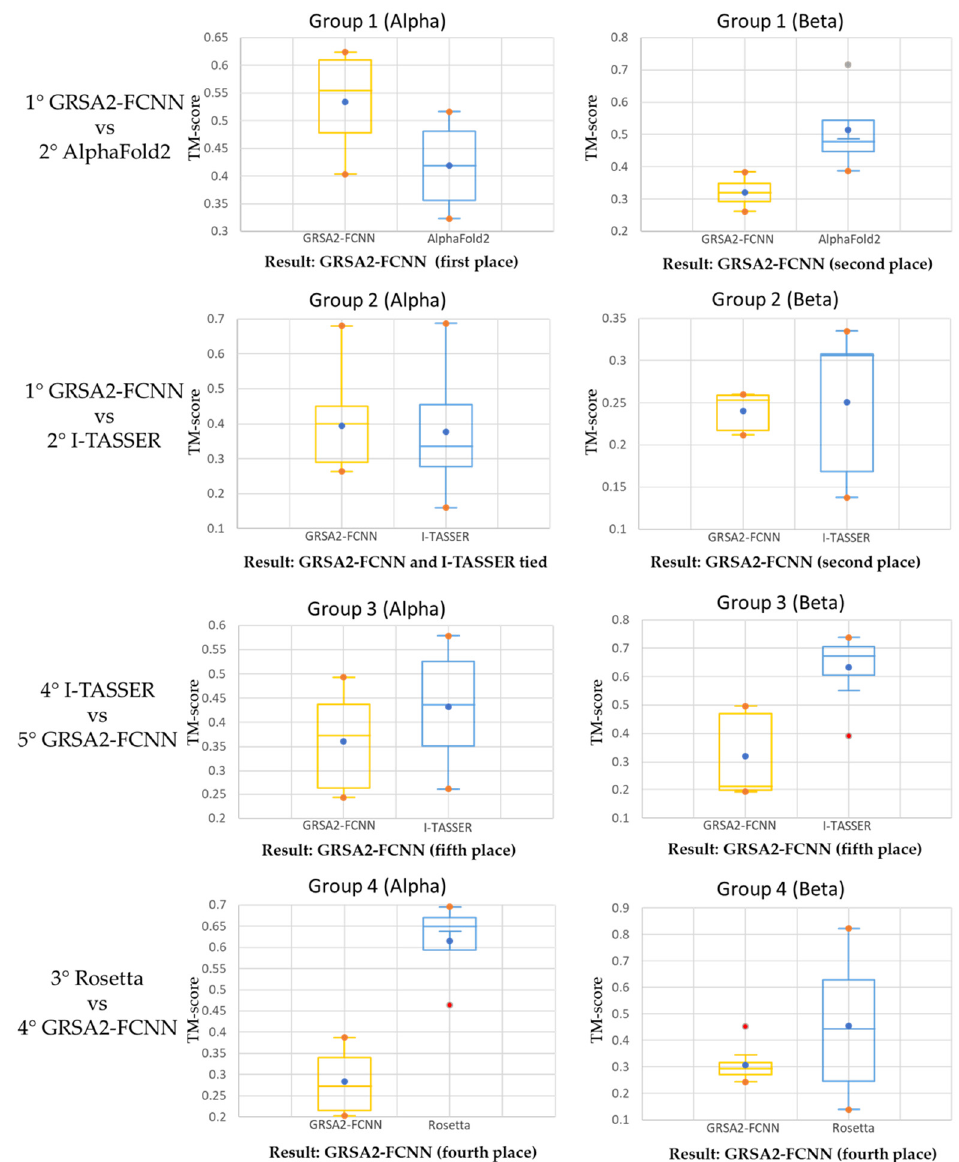
Figure 13. Box plots for alpha and beta structures.